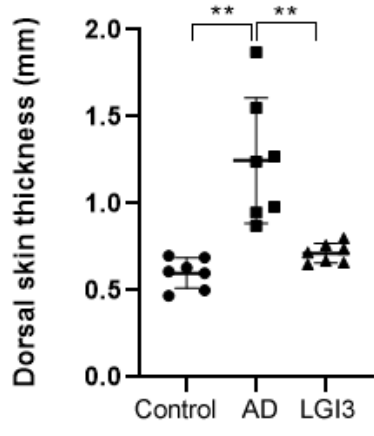
Figure 4. Dorsal skin thickness of mice from each group measured by a thickness gauge (n = 7). The dorsal skin thickness in the leucine-rich glioma inactivated 3 (LGI3) group was not as thick as the atopic dermatitis (AD) group (0.71 ± 0.06 mm vs. 1.25 ± 0.36 mm). Data are expressed as mean ± S.D. (** P < 0.01 vs. AD group). Differences between the control and AD model, LGI3 and AD model group were estimated by ANOVA.